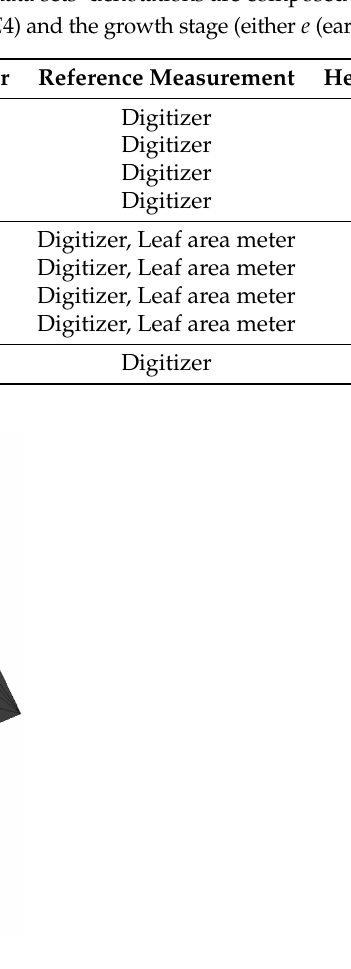
Table 2. Data sets used for the phenotyping. The data sets’ denotations are composed of the plant’s